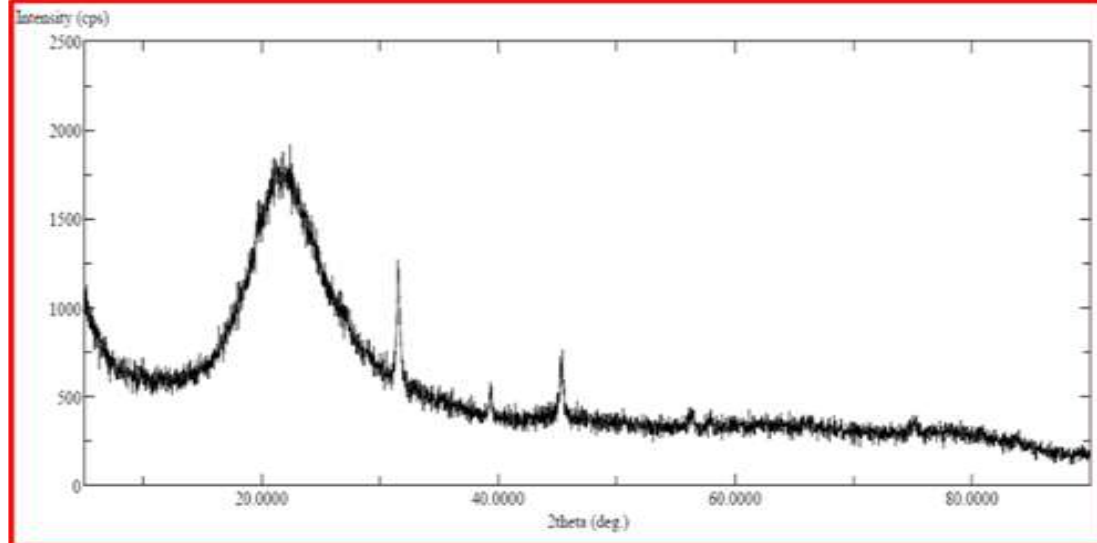
Figure 12. XRD diffraction of the lyophilized F13 Scanning electron microscopy (SEM)